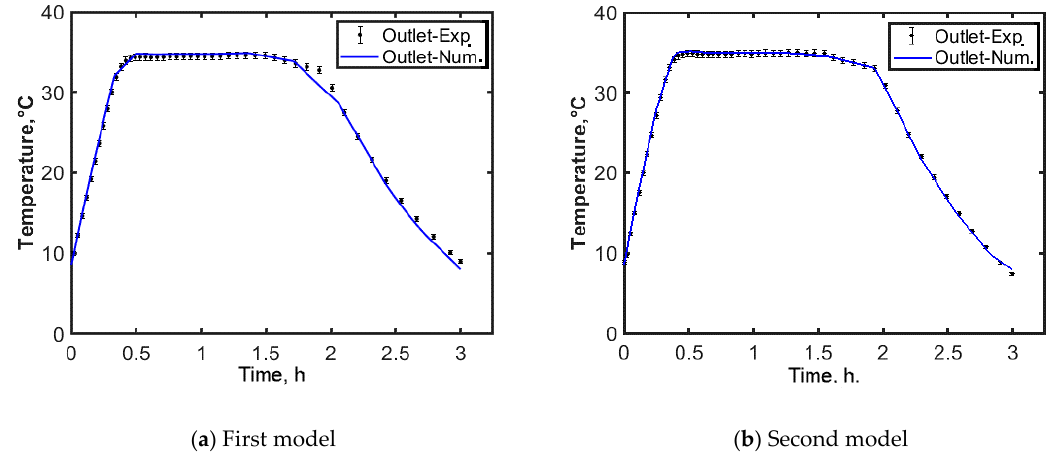
Figure 11. Experimental and numerical outlet temperature at Q = 1471 mL/min.